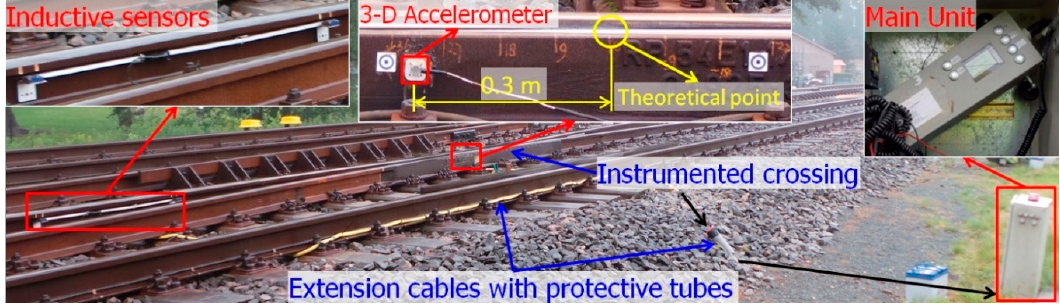
Figure 2. Overview of the crossing instrumentation.